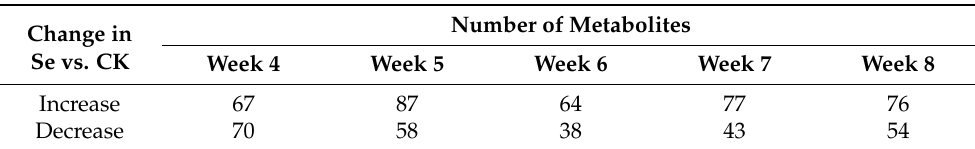
Table 3. Changes in metabolite profiles in the fermentation broth of Epichloë sinensis between Se and control groups during weeks 4–8.